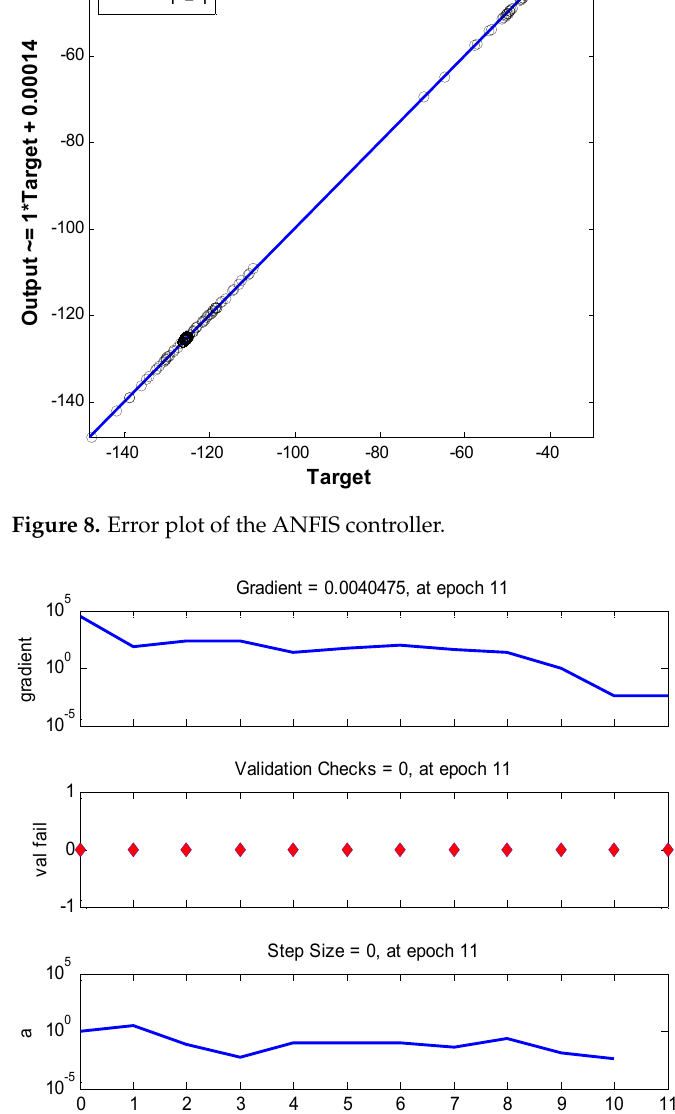
The internal structure of the neural network of the ANFIS controller is shown in Figure 10. In this figure, the inner form of a neural network consists of two main parts: Figure 9. Characteristics of the neural network for hysteresis controller. Figure 9. Characteristics of the neural network for hysteresis controller. Layer 1 and Layer 2.